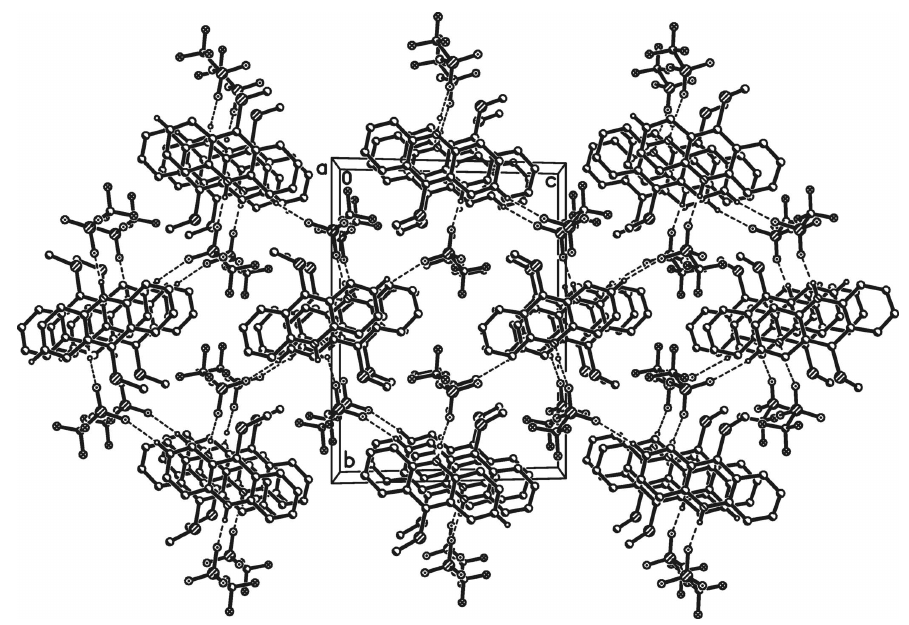
Figure 3 Stacks of the ion pairs in the crystal structure viewed along the a axis. The N–H···O and C–H···O interactions are represented by dashed lines. H atoms not involved in interactions have been omitted. 9-(Methylsulfanyl)acridinium